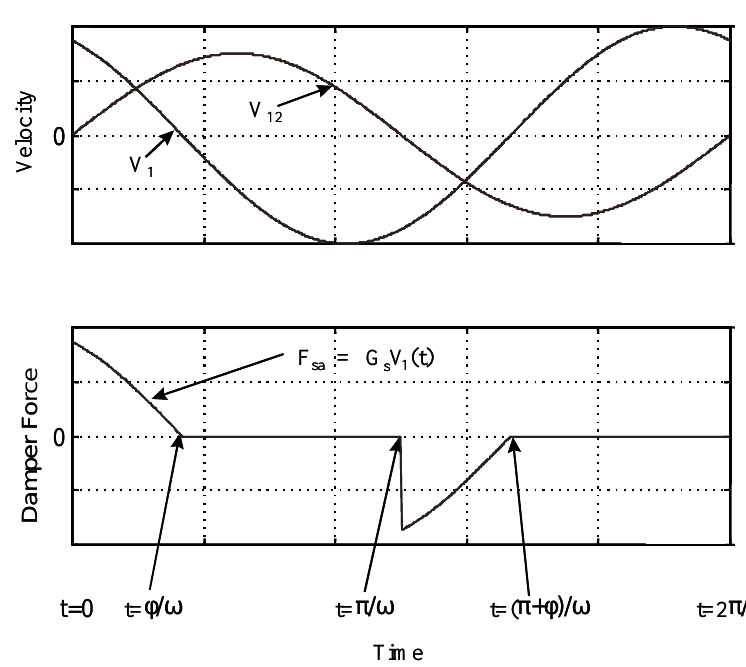
Fig. 12. Relationship between V 1 , V 12 , and damper current due to a pure tone excitation for a continuously variable skyhook